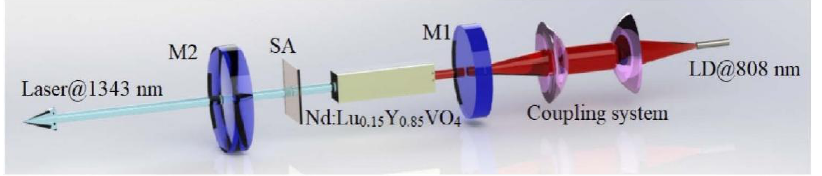
Figure 4. Passively Q-switched 1.34 µm laser experimental device with nickel-cobalt layered dou- ble hydroxide SA [102]. hydroxide SA [102].